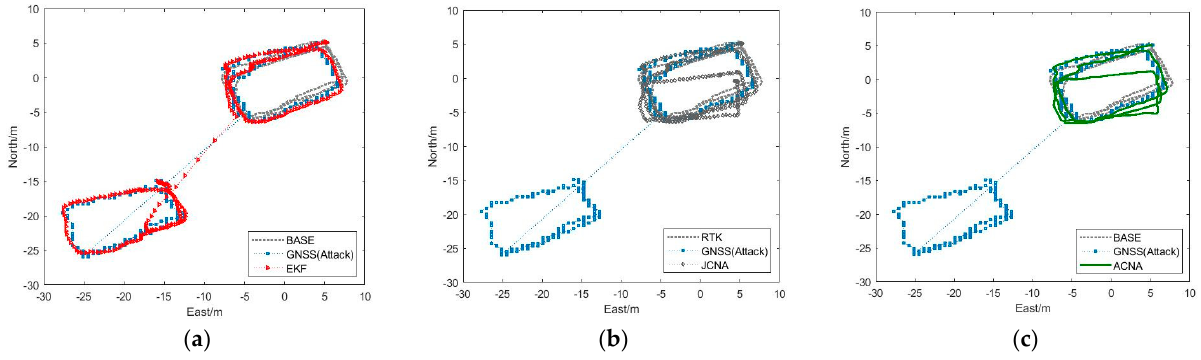
Figure 13. The position error of the three algorithms on data set